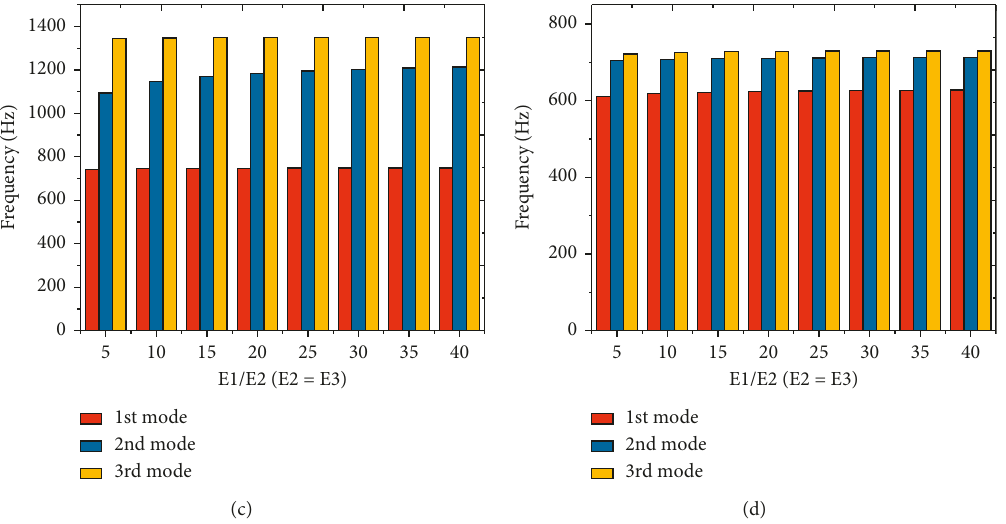
Figure 12: Variation of the first ten frequencies (Hz) against material parameter η ( η � E11/E22) for a thick plate with different boundary conditions: (a) CCCC; (b) SSSS; (c) E1E1E1E1; (d)